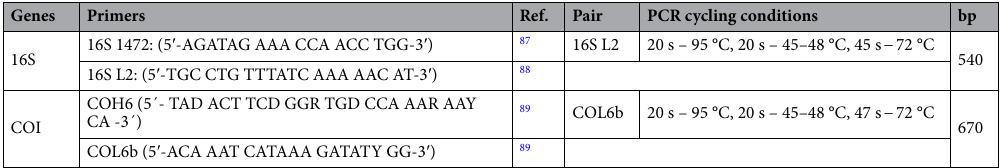
Table 6. Data of sequenced genes, 16S and COI, including primers used for each gene, and reference (Ref), cycling conditions of the PCR, in all cases: initially 2 min at 95 °C and finally 5 min at 72 °C (35–40 cycles), and length, number of base pairs, of the sequences obtained